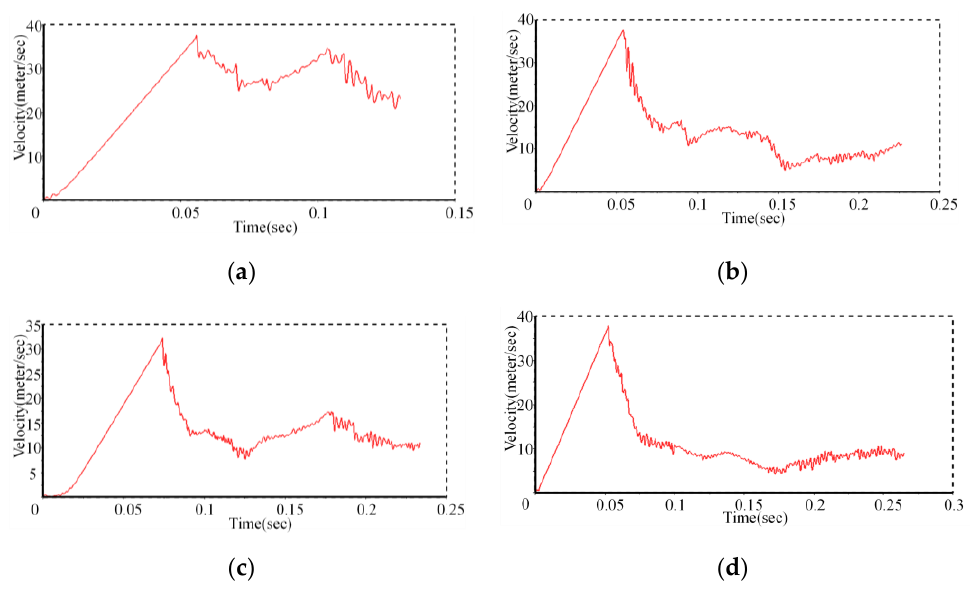
Figure 9. Movement speed of different cup interval ratios: ( a ) cup spacing ratio of 3%; ( b ) cup spacing ratio of 10%; ( c ) cup spacing ratio of 7%; and ( d ) cup spacing ratio of 8%.